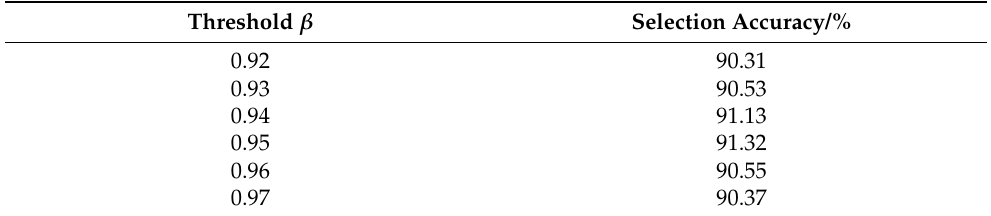
Table 2. Comparison of the performance of different thresholds for positive and negative sample se- lection.